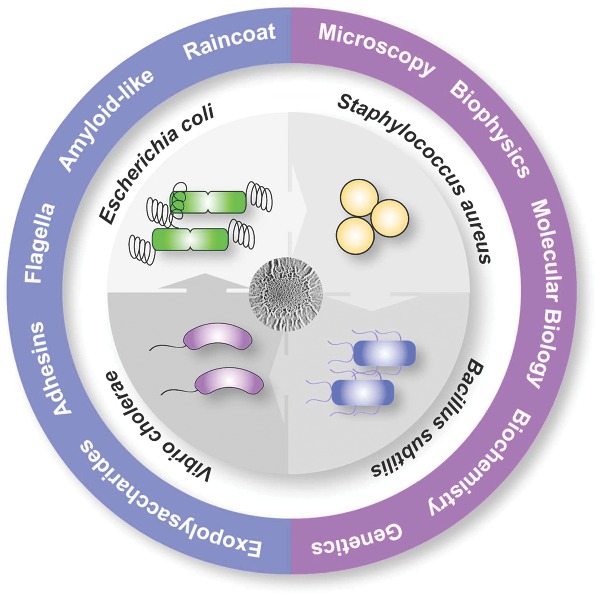
Examining the structure and function of the biofilm extracellular matrix.